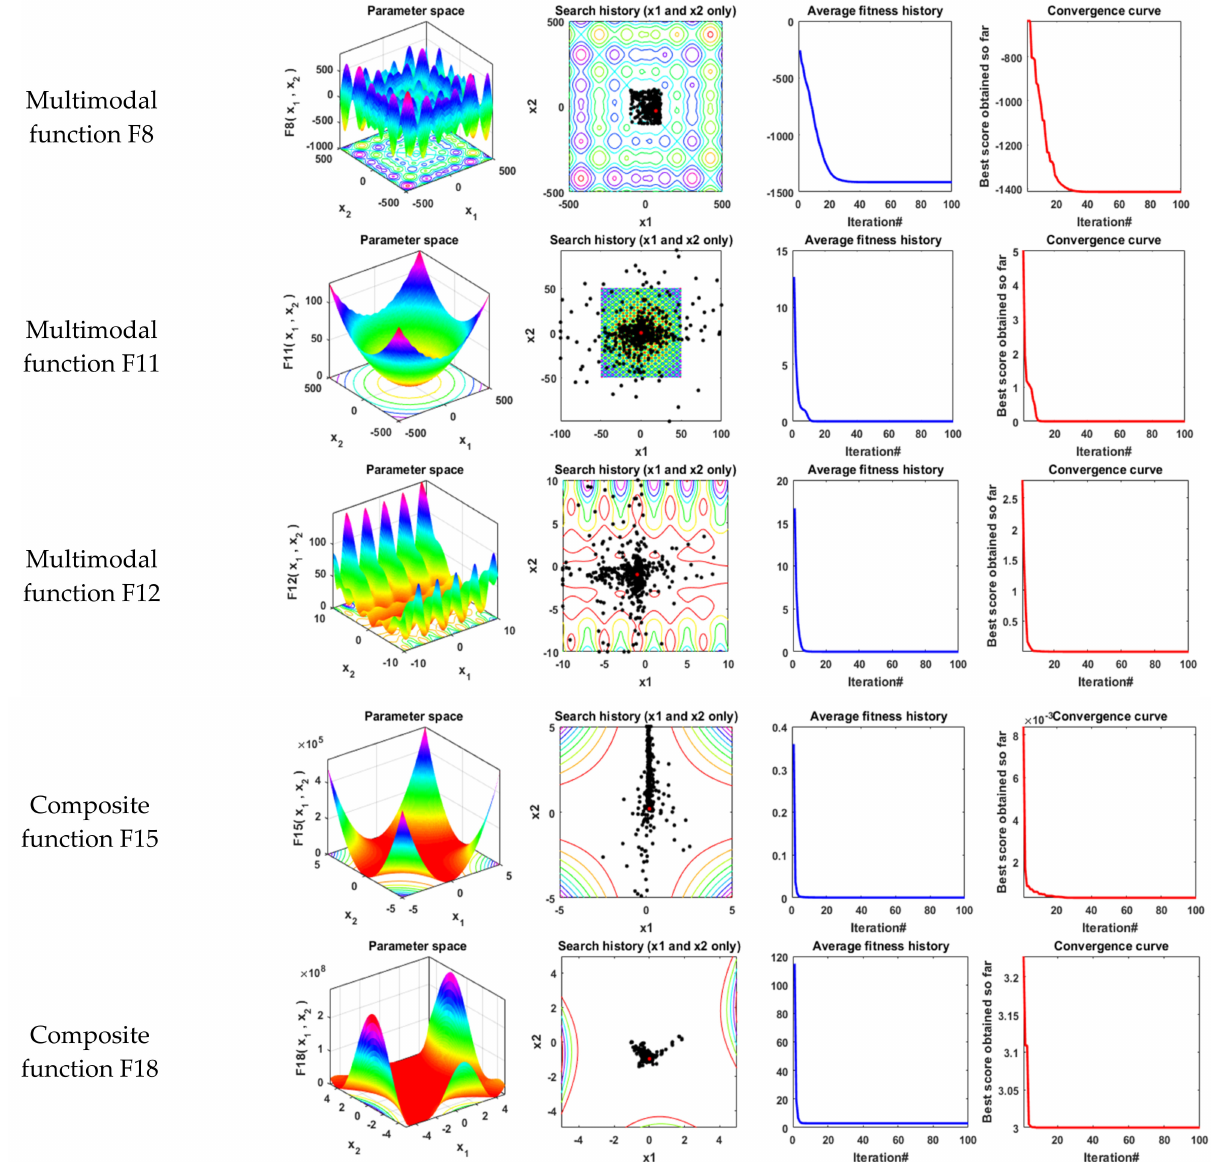
Figure 10. Qualitative metrics of nine benchmark functions using the proposed quantum chaos game optimizer algorithm: 2D views of the functions, search history, average fitness history, and convergence